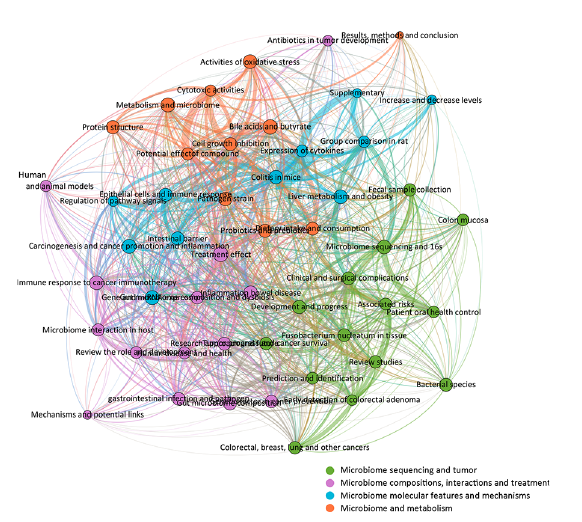
FIGURE 5 Network correlational and cluster analysis of the 50 topics. Four main clusters were identi fi ed and colored, respectively. Green, microbiome sequencing and tumor; violet, microbiome compositions, interactions, and treatments; blue, microbiome molecular features and mechanisms; orange, microbiome and metabolism.